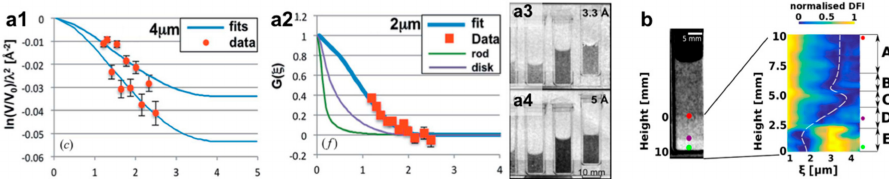
Figure 5. Quantitative neutron grating interferometry dark-field imaging (NGI-DFI): ( a ) spherical polystyrene particles diluted in H2O/D2O; loss of concentration observed over time (sedimentation) of 4 µ m particles ( a1 ); results corresponding to form factor of spherical particles with dimeter of 2 µ m measured ( a2 ); ( a3 , a4 ) corresponding dark-field images at 3.3 Å and 5 Å, respectively [44]; ( b ) DFI of polystyrene spheres sedimenting in an aqueous dilution where a diluted phase a concentrated phase and a quasi-crystalline phase can be identified and in particular a depletion zone (C) between high concentration and crystallization regions is found [46]; (a1) to (a4) are reproduced with permission of the International Union of Crystallography from